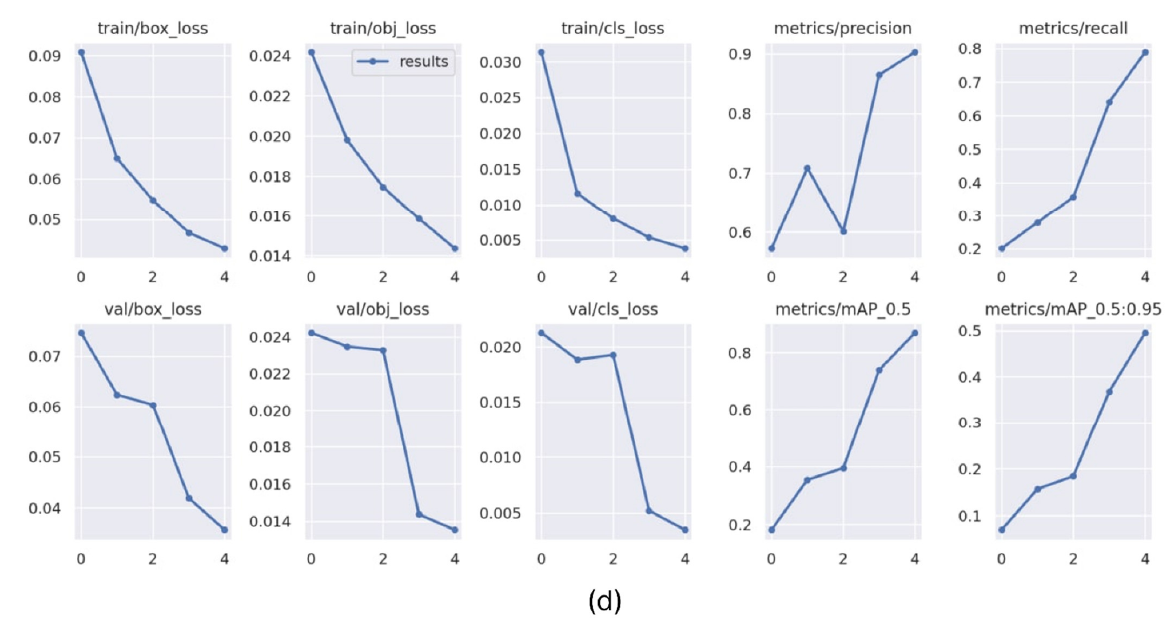
Sensors 2022 , 22 , x FOR PEER REVIEW Figure 8. First case model training and validation metrics for a set of counter images. Additionally, for a qualitative result obtained from the examination, we collected pairwise graphs of the dependence of the quality metrics of the algorithm used, such as precision, recall, f1, and confidence (Figure 9).